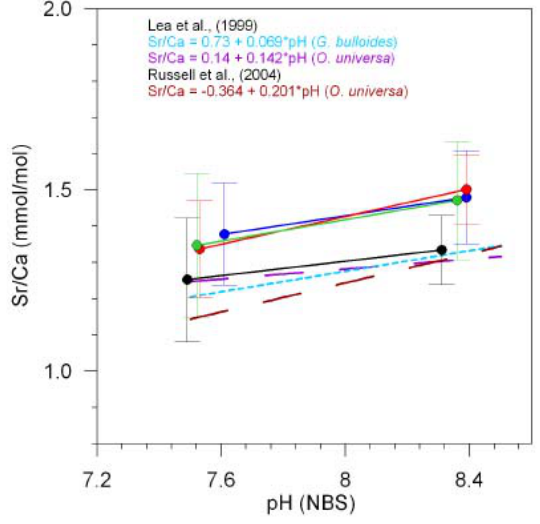
Fig. 7. Sr/Ca ratios in Ammonia tepida (solid lines -this study-, average of the Sr/Ca ratios calculated per experimental condition, same color code used as in Fig. 6), in Orbulina universa (dashed lines, Lea et al., 1999 and Russell et al., 2004) and in Globigeri- noides bulloides (doted lines, Lea et al., 1999), versus pH